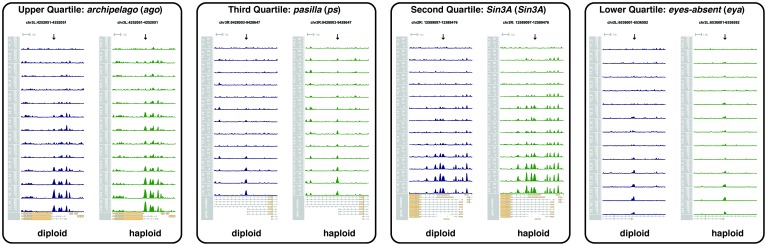
Examples of regions that gain accessibility independently of the N:C ratio.Each plot shows the accessibility profiles over time for diploid (left, blue, NC11 to NC13) and haploid (right, green, NC12 to NC14) samples at four regions selected on the basis of the distribution of open ATAC-seq coverage within the total set of N:C-ratio-independent peaks. The y-axis shows coverage of open ATAC-seq reads at an equal scale for all eight plots. The x-axis shows a 10 kb region centered over the peak region of interest (arrow, coordinates provided at top of plots). The gene models mapping to the displayed region are shown at bottom (yellow). An N:C-ratio-independent region is expected to gain accessibility at equivalent nuclear cycles, not equivalent nucleo-cytoplasmic ratios. The timecourses for diploid and haploid samples are aligned by equivalent nucleo-cytoplasmic ratios. As such, it is expected that N:C-ratio-independent peaks show greater accessibility earlier (higher up on the plots) in haploids compared with diploids.